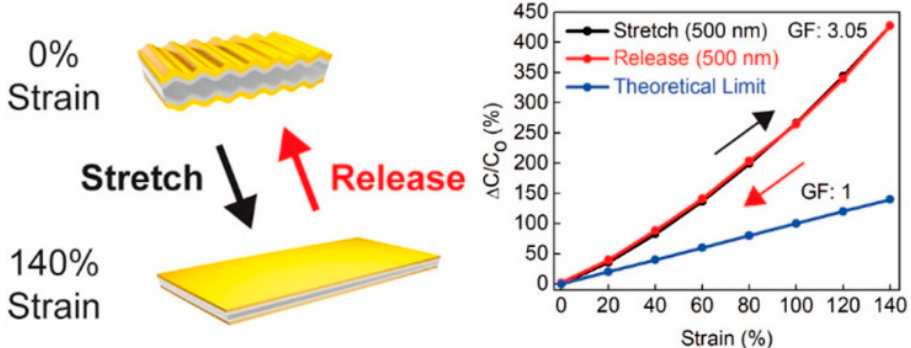
Figure 1. Illustration of a capacitive strain sensor ( left ), and capacitive response curves during loading and unloading ( right ). Reprinted with permission from [43]. Copyright 2018 American Chemical Society.